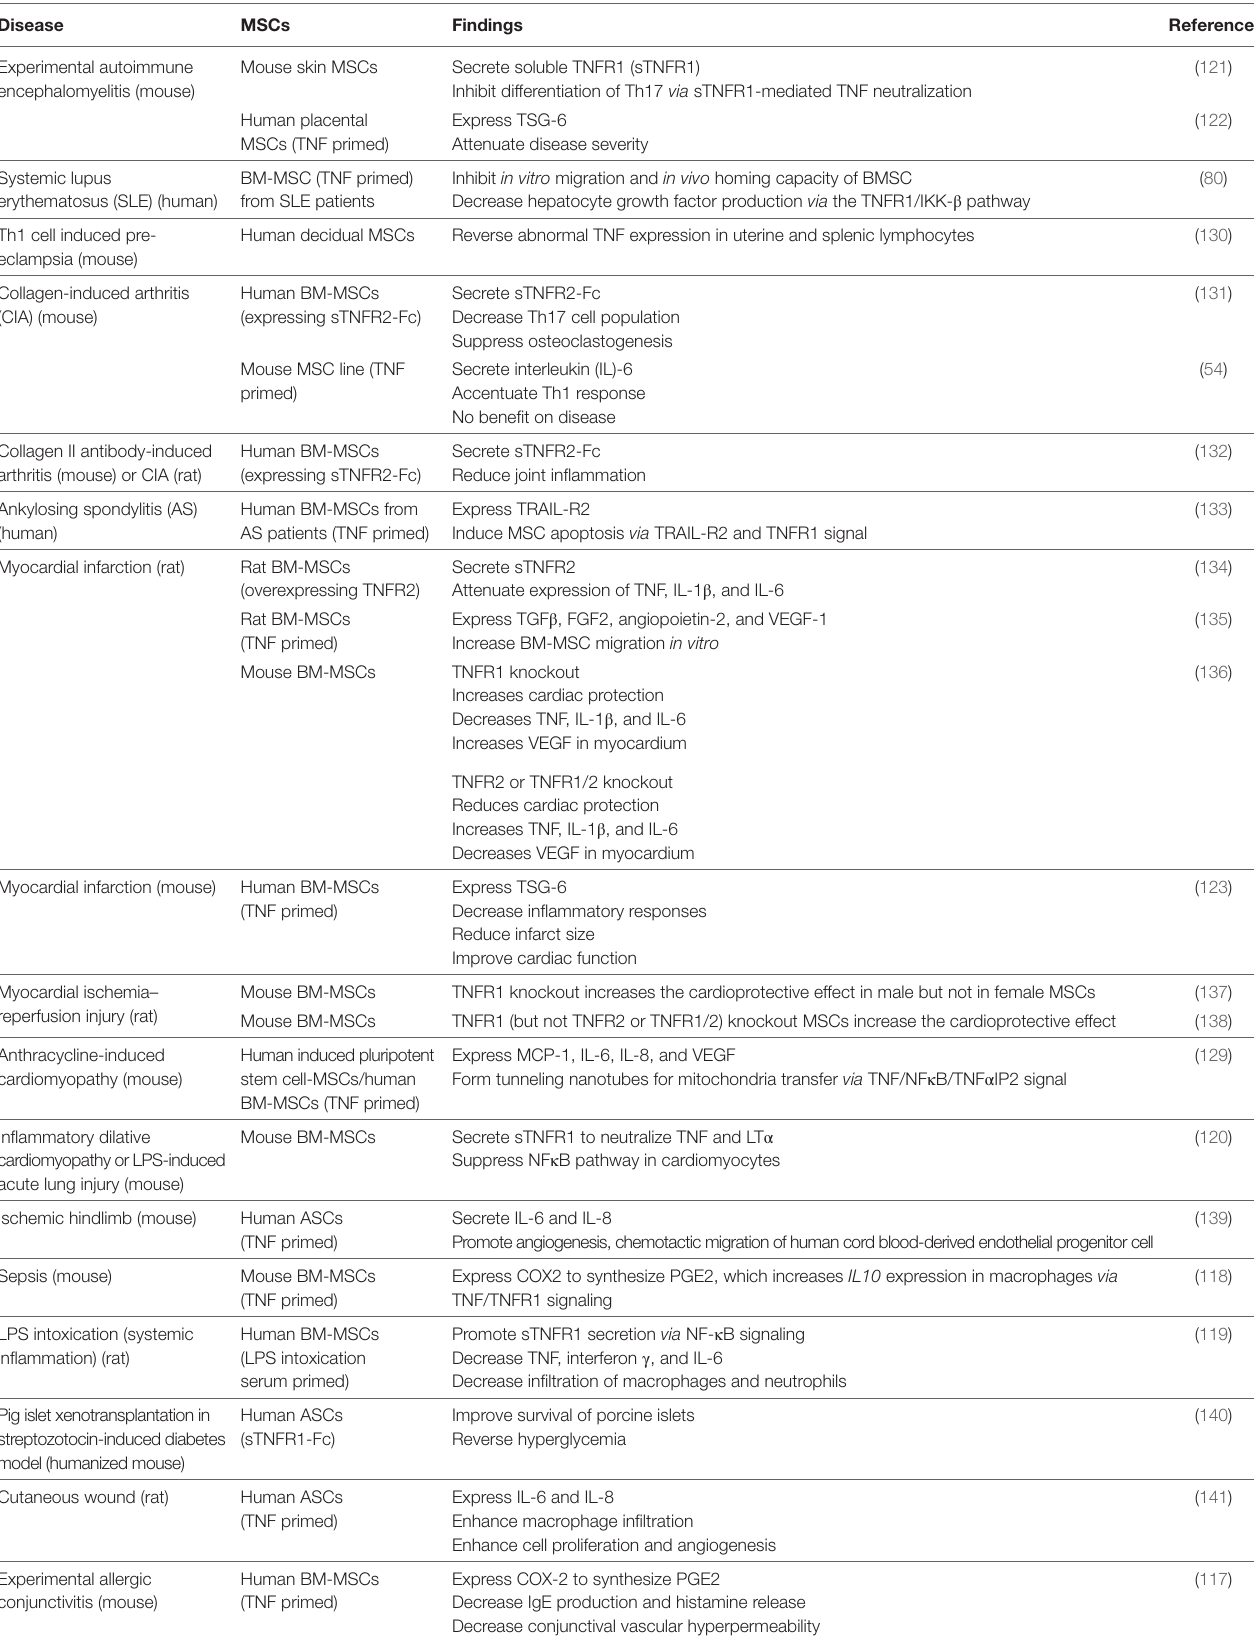
TABLe 1 | Tumor necrosis factor (TNF) regulation of mesenchymal stem cell (MSC) efficacy on autoimmune and inflammatory diseases.